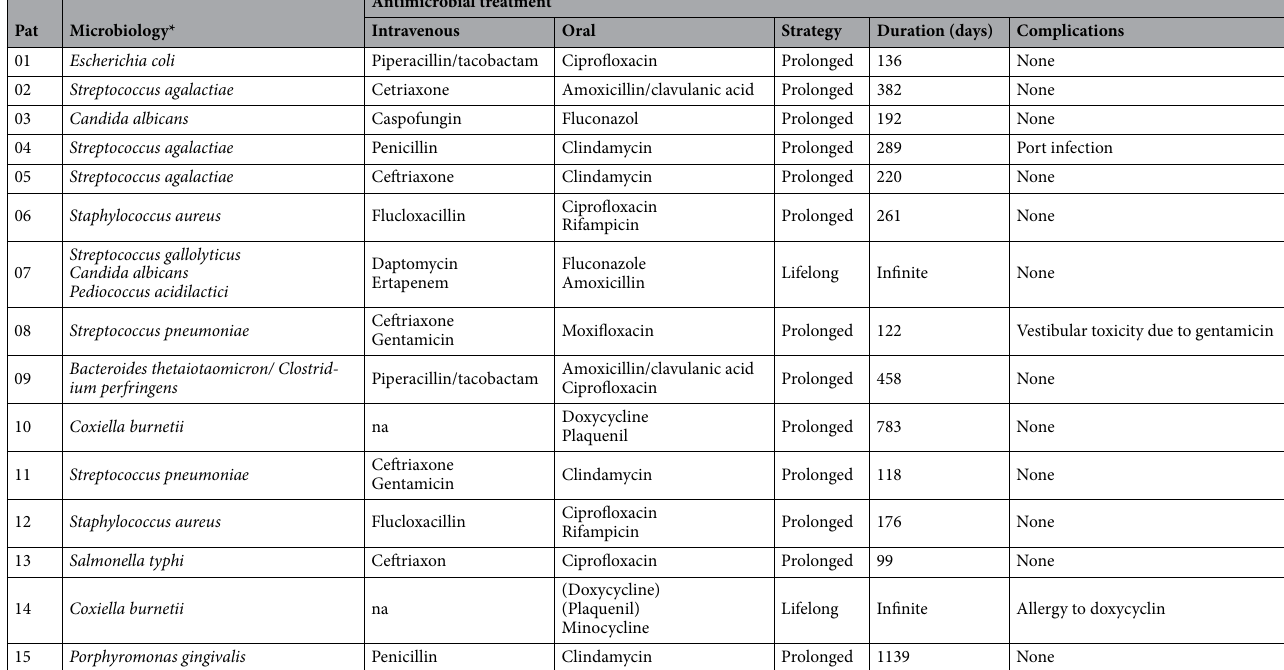
Table 2. Data on microbiology and antimicrobial of the final study population in patients with proven infective native aortic aneurysms. Pat: Patient number; na, not applicable. *Microbiology resulted from blood culture (n = 11), culture or PCR from tissue obtained during surgical revision (n = 2) and serology (n =